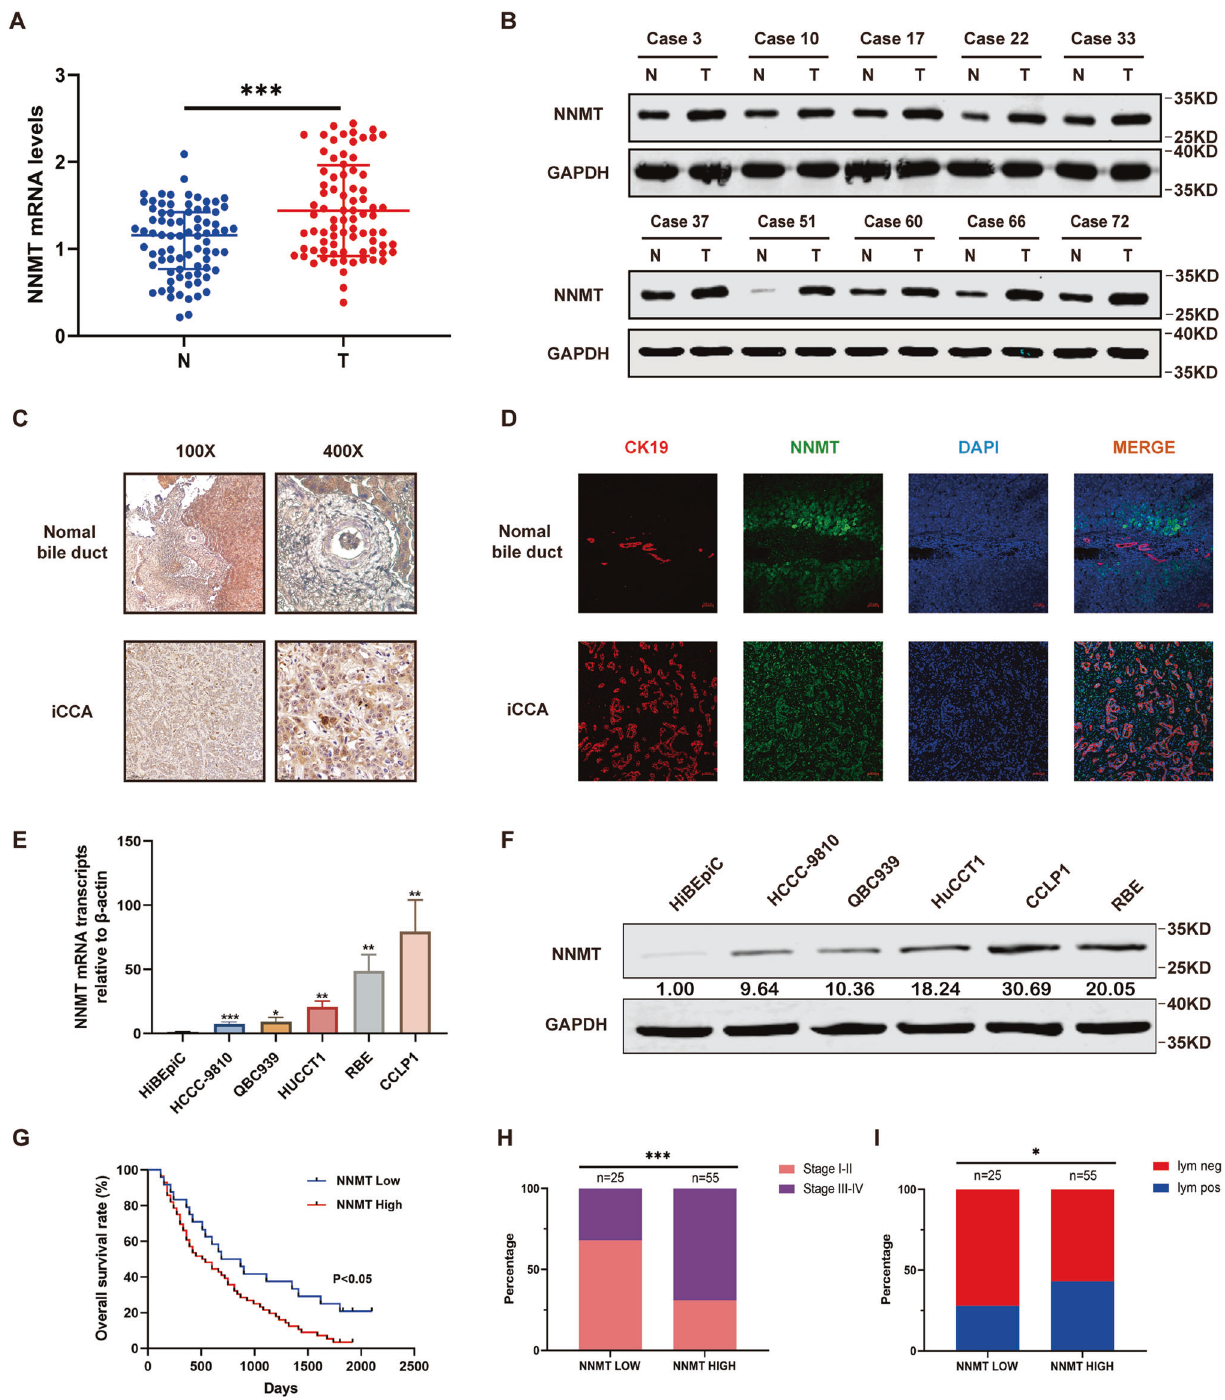
Fig. 1 NNMT is expressed at high levels in iCCA tissues and cell lines. A , B The expression levels of the NNMT mRNA ( A ) and protein ( B ) in iCCA and adjacent tissues. C Representative images of NNMT IHC staining in iCCA tissues and adjacent tissues. Scale bars, ×100: 100 μ m; ×400: 20 μ m. D Representative images of NNMT IF staining in iCCA tissues and adjacent nomal bile duct tissues. Scale bars, 50 μ m. E , F The expression levels of the NNMT mRNA ( D ) and protein ( E ) in various iCCA cell lines and normal bile duct cell line. G Kaplan – Meier curves of patients segregated by low/negative or high expression of NNMT. H Percentage of patients with AJCC stage I – IV iCCA segregated by low or high expression of NNMT. I Percentage of patients with lymph node metastases segregated by low or high expression of NNMT (data are mean ± SEM, * P < 0.05, ** P < 0.01, *** P < 0.001, n = malignant transformation. However, the potential mechanism of NNMT in iCCA is unclear. In the present study, we found that NNMT promotes the proliferation and metastasis of iCCA cells by these tumors positively correlates with tumor size and progres- activating the EGFR-STAT3 signaling pathway. sion, suggesting that NNMT may regulate the initial stage of